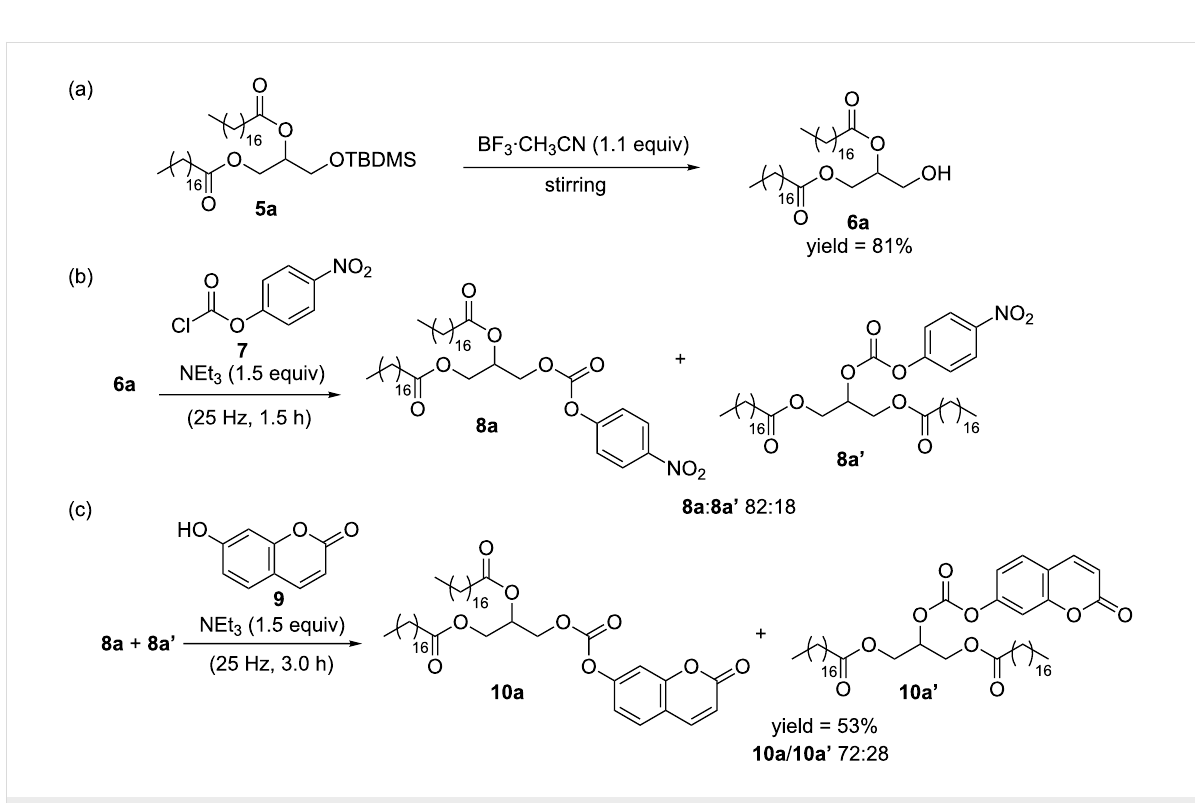
Scheme 5: Conjugation of DAG 5a with 7-hydroxycoumarin ( 9 ).